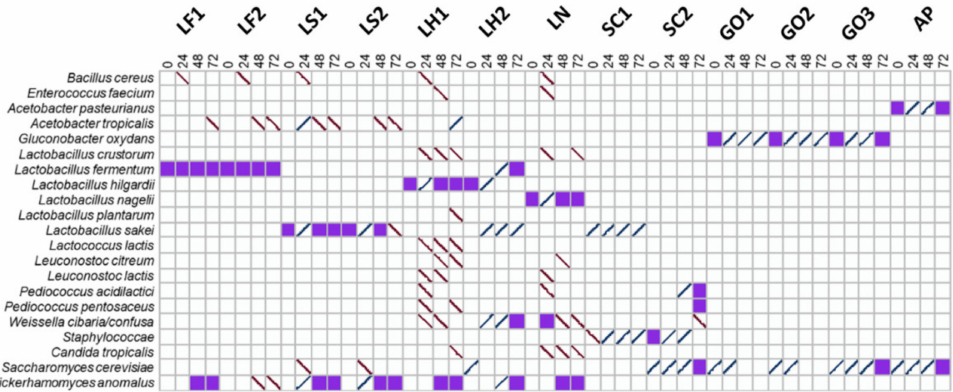
Figure 3. Microbial community dynamics during starter culture-initiated sourdough productions as determined by culture-dependent and culture-independent microbiological methods. The indication of the starter culture strains is as in Table 1. The species found both culture-dependently (molecular identificationofpickedisolatesandPCR-DGGEofplatewashes)andculture-independently(PCR-DGGE of fermentation samples) are indicated as purple squares, and those found only culture-dependently are indicated with downward stripes ( \ ), whereas those found only culture-independently are indicated with upward stripes ( /